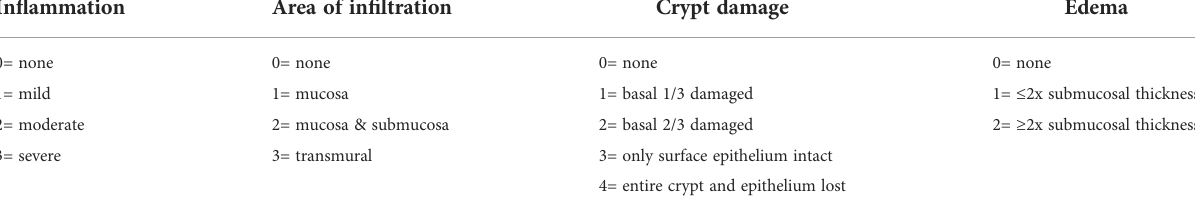
TABLE 1 Histology scoring of DSS